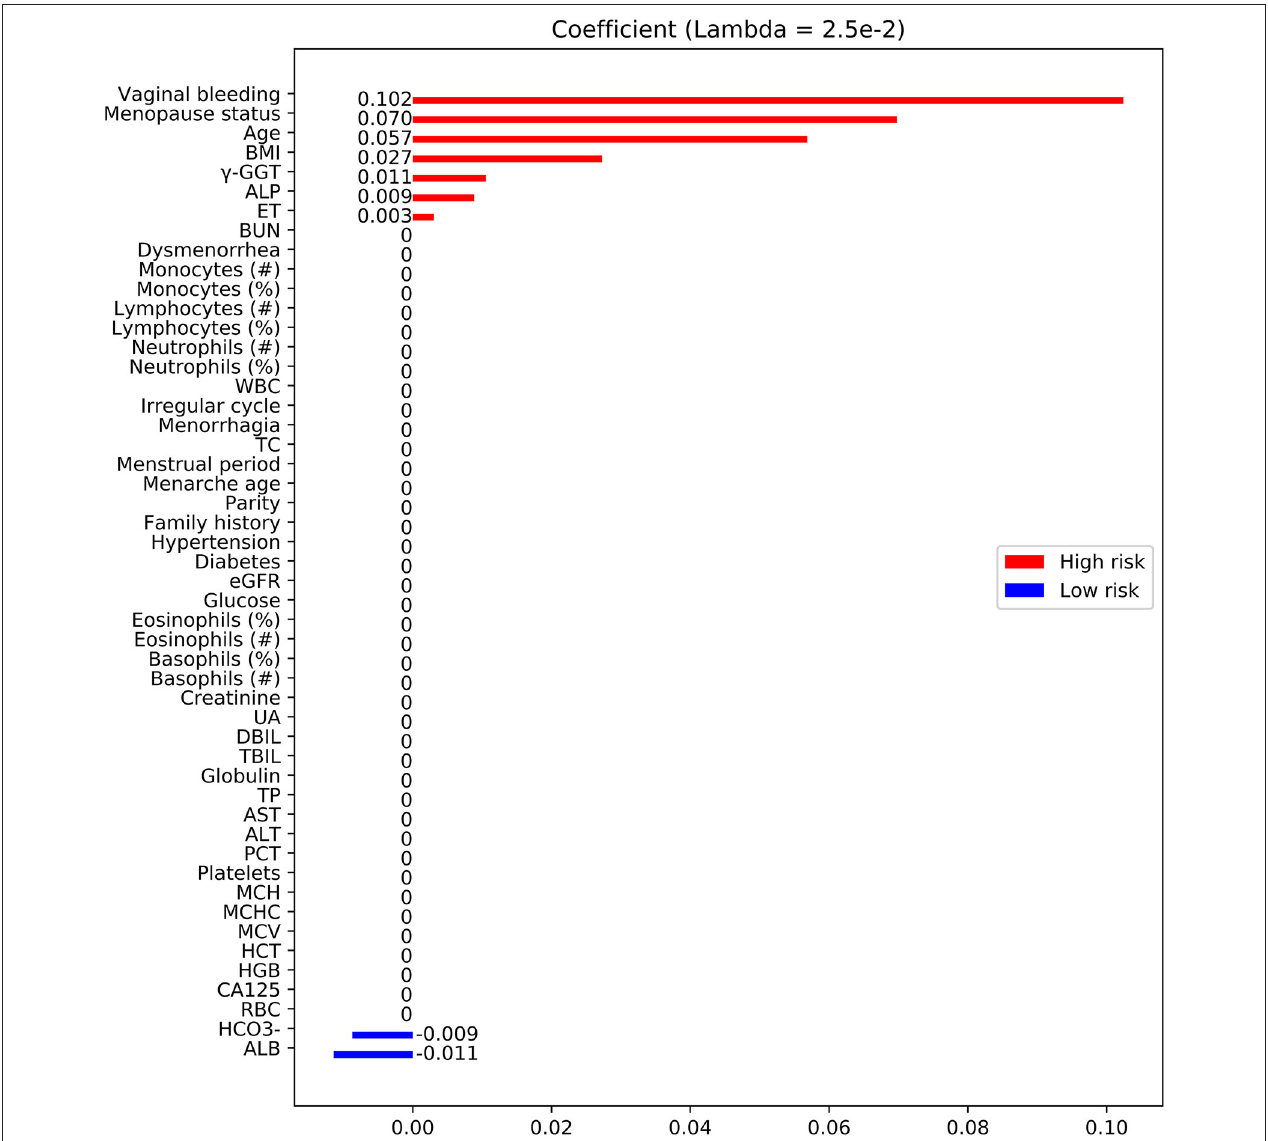
FIGURE 2 | Feature selection using LASSO. Feature coefficients revealed high-risk (red bar) and low-risk (blue bar) features, which were selected using LASSO with an optimal lambda value of 2.5 × 10 − 3 . BMI, body mass index; TBIL, total bilirubin; ALP, alkaline phosphatase; BUN, blood urea nitrogen; γ -GGT, γ -glutamyl transpeptidase; ET, endometrial thickness; TC, total cholesterol; AST, aspartate aminotransferase; CA-125, cancer antigen 125; UA, uric acid; Diabetes, type 2 diabetes; Family history, family history of malignant diseases; WBC, white blood cell; RBC, red blood cell; ALT, alanine aminotransferase; HGB, hemoglobin; PCT, thrombocytocrit; MCH, mean corpuscular hemoglobin; MCV, mean corpuscular volume; HCT, hematocrit; eGFR, estimated glomerular filtration rate; MCHC, mean corpuscular hemoglobin concentration; TP, total protein; DBIL, direct bilirubin; ALB, albumin; HCO − 3 , concentrations of